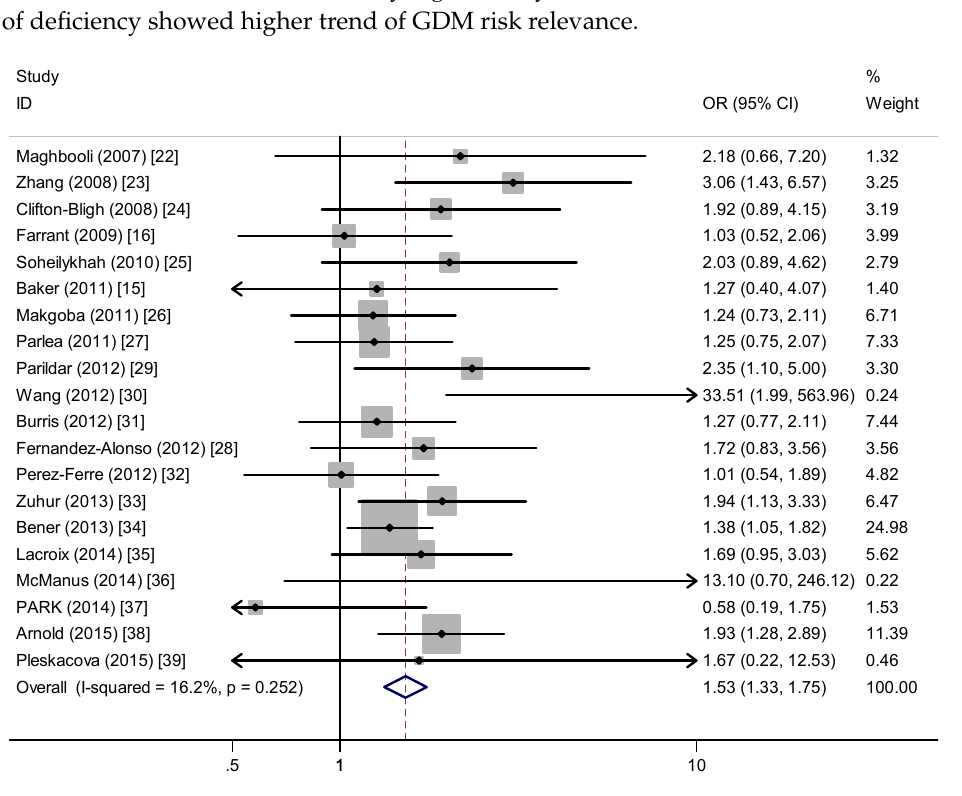
Figure 2. Meta-analysis of the association between vitamin D deficiency and risk of gestational diabetes mellitus (GDM).